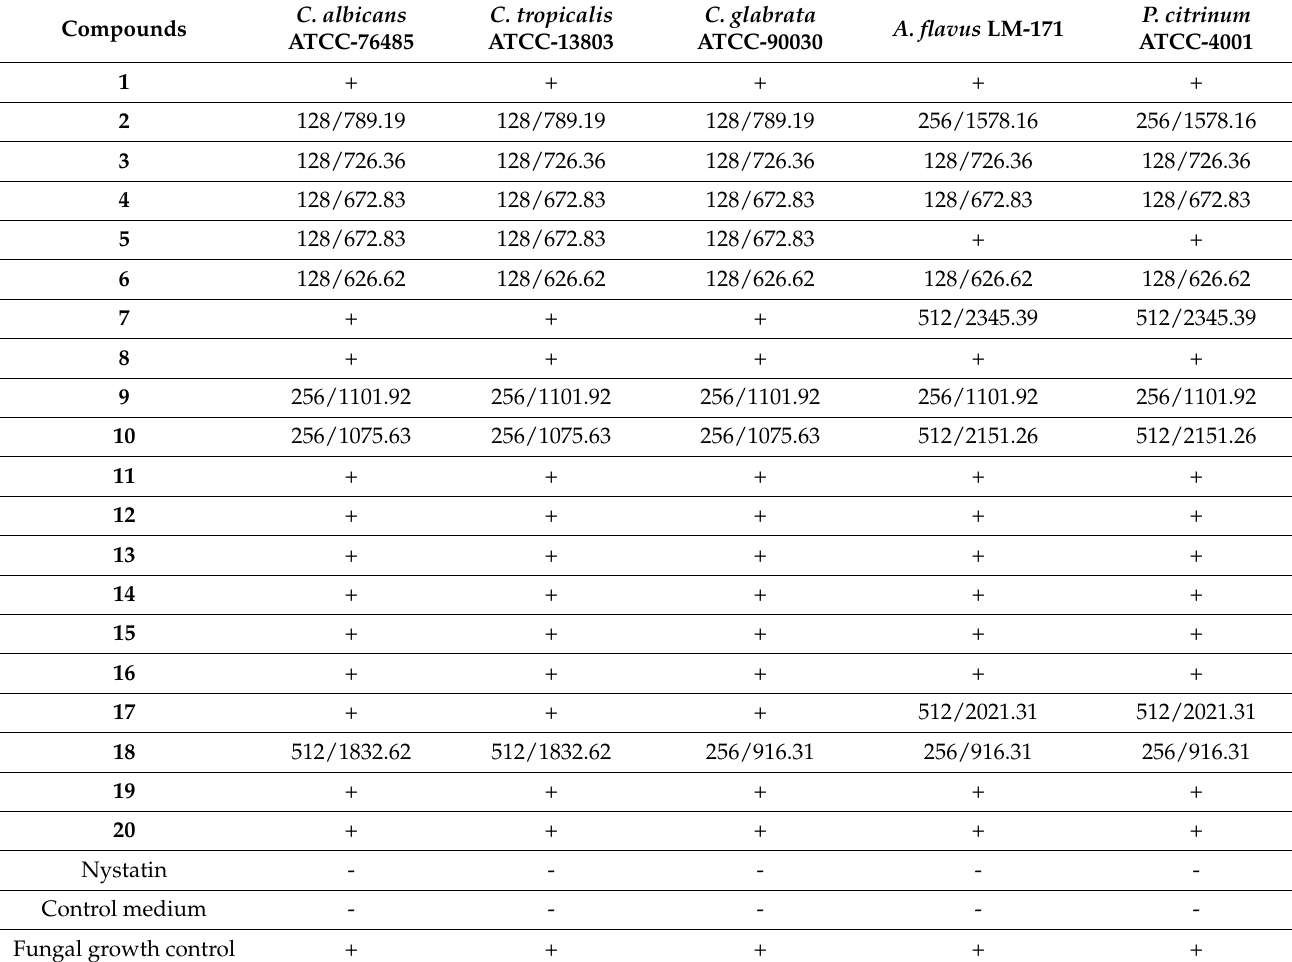
Table 1. MIC ( µ g/mL and µ M) of compounds 1 – 20 against fungal